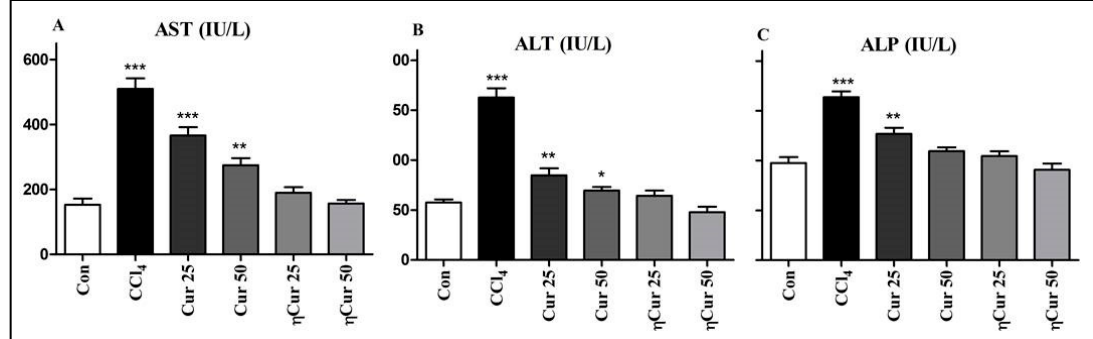
Figure 4. Changes in the level of liver damage marker enzymes in the serum. Graphs showing ( A ) aspartate transaminase (AST), ( B ) alanine transaminase (ALT) and ( C ) alkaline phosphatase (ALP) levels in control (Con) and experimental animals. CCl 4 —group of animals that received only carbon tetrachloride, Cur 25—group of animals orally administered with 25 mg/kg free curcumin after carbon tetrachloride injection, Cur 50—group of animals orally administered with 50 mg/kg free curcumin after carbon tetrachloride injection, η Cur 25—group of animals orally administered with 25 mg/kg curcumin in the form of nanoparticles after carbon tetrachloride injection, η Cur 50—group of animals orally administered with 50 mg/kg curcumin in the form of nanoparticles after carbon tetrachloride injection. Values marked with asterisks in a graph are significantly different from the respective control as analyzed by Student’s t-test (* p ˂ 0.05, ** p ˂ 0.01 and *** p ˂ 0.001). Data are presented as mean ± SD of three replications.